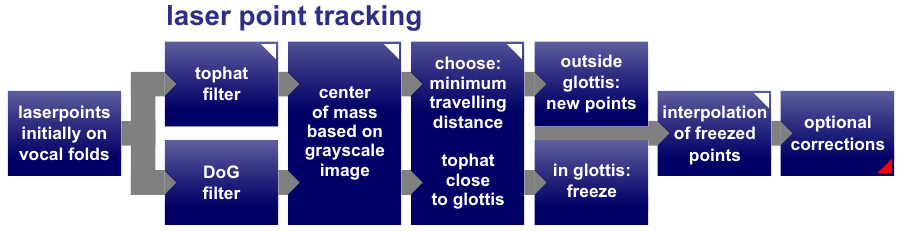
Figure 11. Flowchart of the laser point tracking. White corners indicate new processing steps and red corners indicate a necessary or optional user